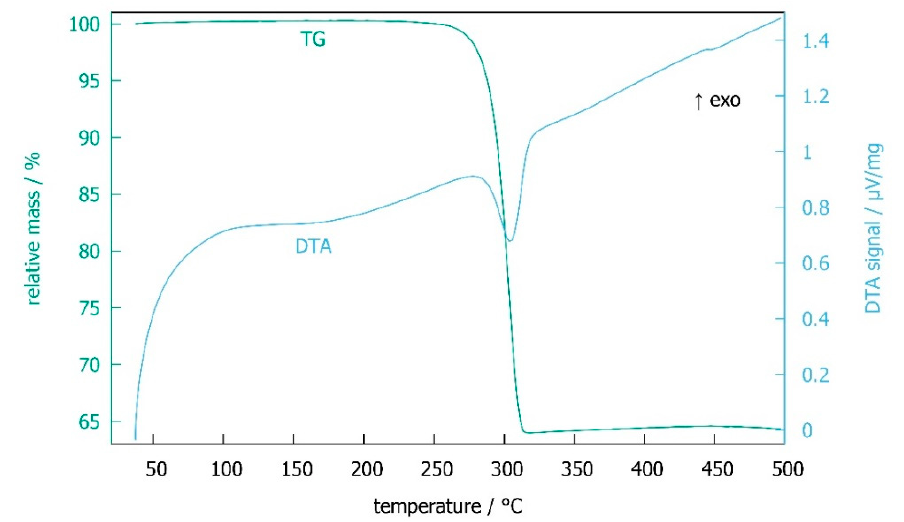
Figure 3. Differential scanning calorimetry (blue) and thermogravimetry (green) of SbC 2 O 4 OH.